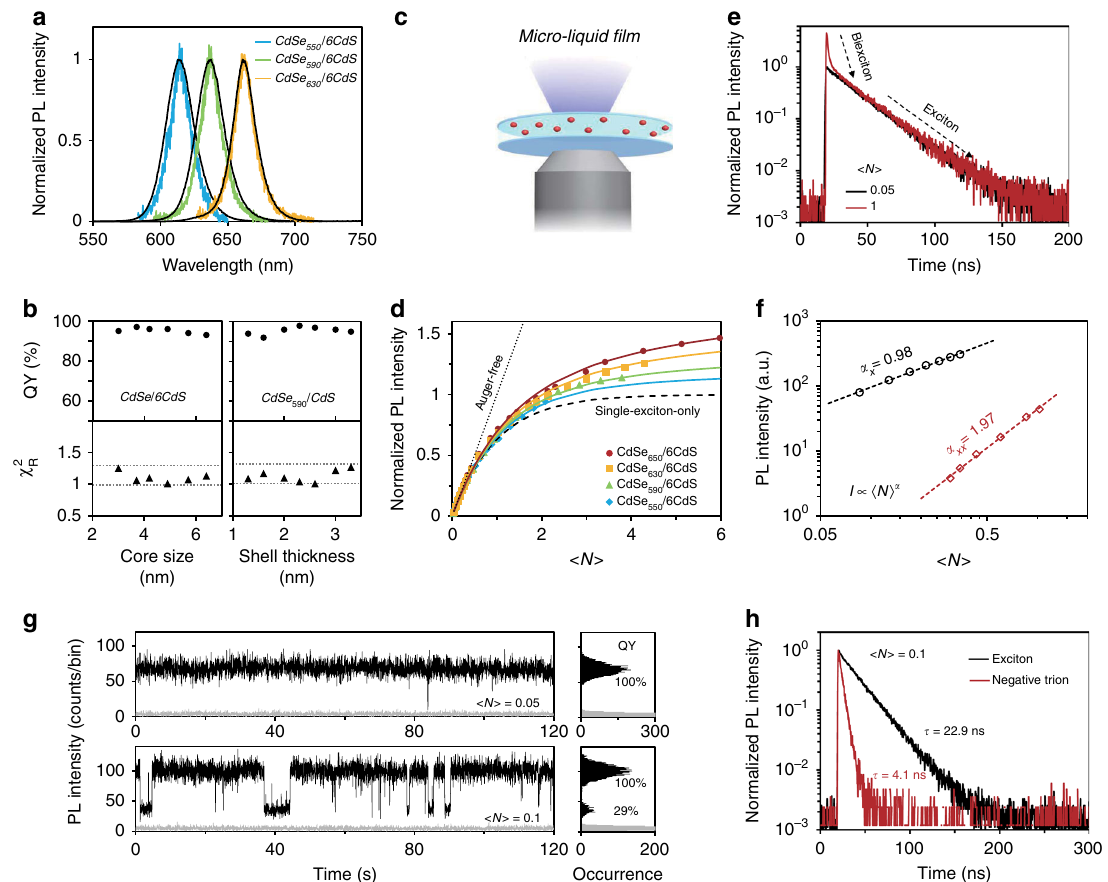
Fig. 1 Optical properties of exciton, biexciton and trion for CdSe/CdS core/shell quantum dots (QDs). a Normalized photoluminescence (PL) spectra of representative single (color-coded) and the corresponding ensemble (black) QDs with different CdSe core sizes (the fi rst-exciton absorption peak of CdSe core at 550, 590, and 630 nm, respectively) and six monolayers of CdS shell. b PL QYs and the goodness-of- fi t ( χ R 2 ) for mono-exponential fi tting of PL decay curves for CdSe/CdS QDs with different core sizes or shell thicknesses. χ R 2 = 1.30 and 1.00 are represented by dotted lines. c Schematic of a micro- liquid fi lm of QDs excited by a microscope objective. d Pump-power dependence of PL intensity for four representative QD samples with different core sizes but the same shell thickness measured by the micro-liquid fi lm approach. Solid lines are the fi ts to the ‘ PL saturation ’’ model. The dashed and dotted lines are the PL saturation models with multi-exciton QY being 0% and 100%, respectively. e PL decay curves of CdSe 630 /6CdS core/shell QDs as an representative sample with low (black) and relatively high (red) excitation power measured by the micro-liquid fi lm approach. f Excitation power dependence of PL intensity of single-exciton (black circles) and biexciton (red diamonds). The slopes in the log – log plot for both channels match the expected values. g Representative PL intensity trajectories (black) of CdSe 630 /6CdS core/shell QDs under different excitation power with background noises (gray) and the corresponding histograms. Bin time is 30 ms. h PL decay curves of the photons from the bright (black) and dim state (red) corresponding to e (< N >